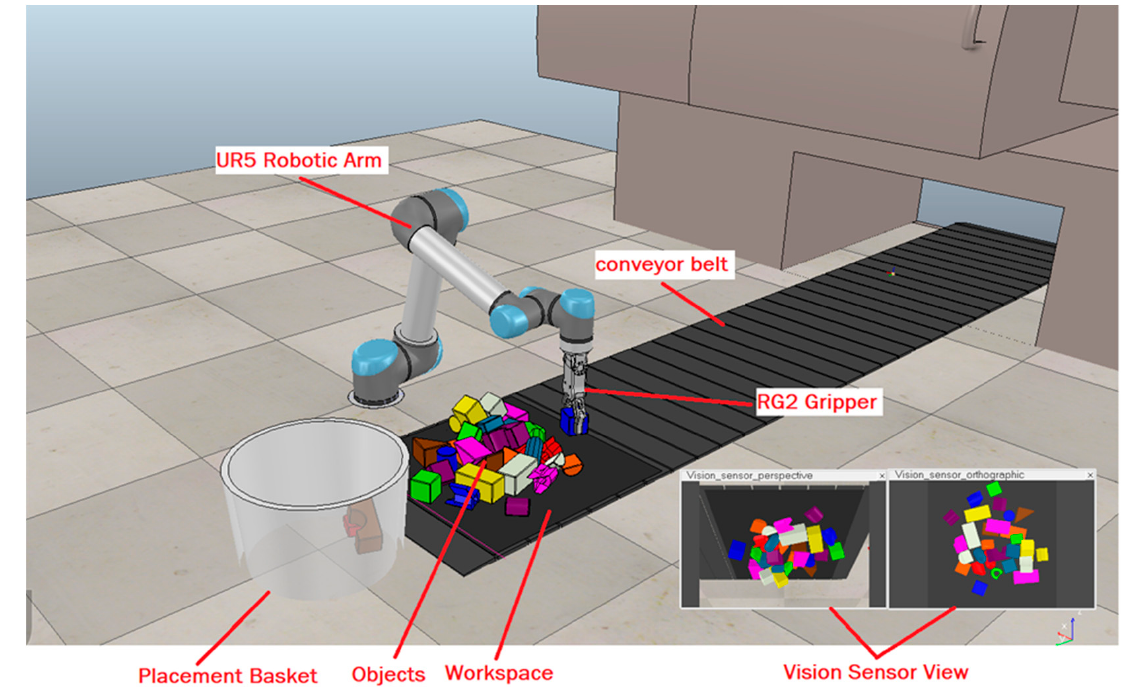
Figure 11. Whole simulation scene designed in V-REP.